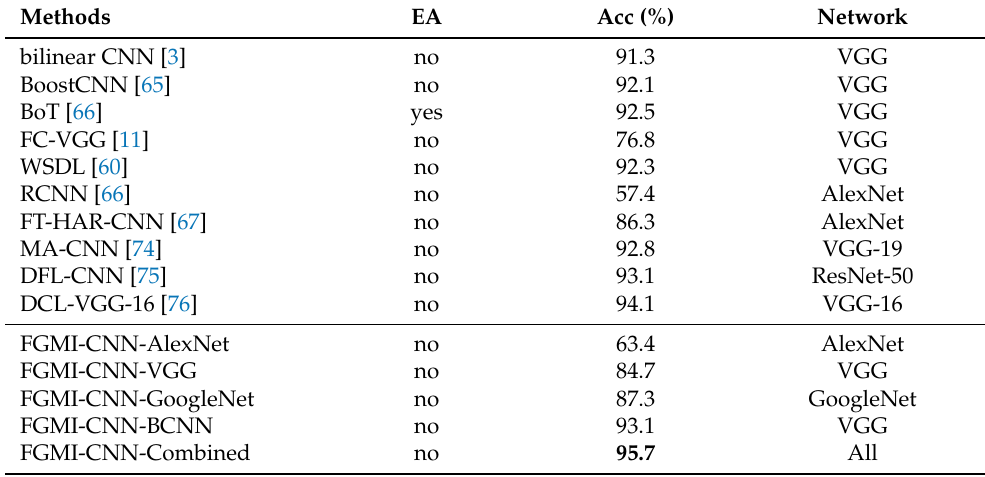
Table 4. Fine-grained classification performances of FGMI-CNN and other baseline methods on the Cars-196 dataset.